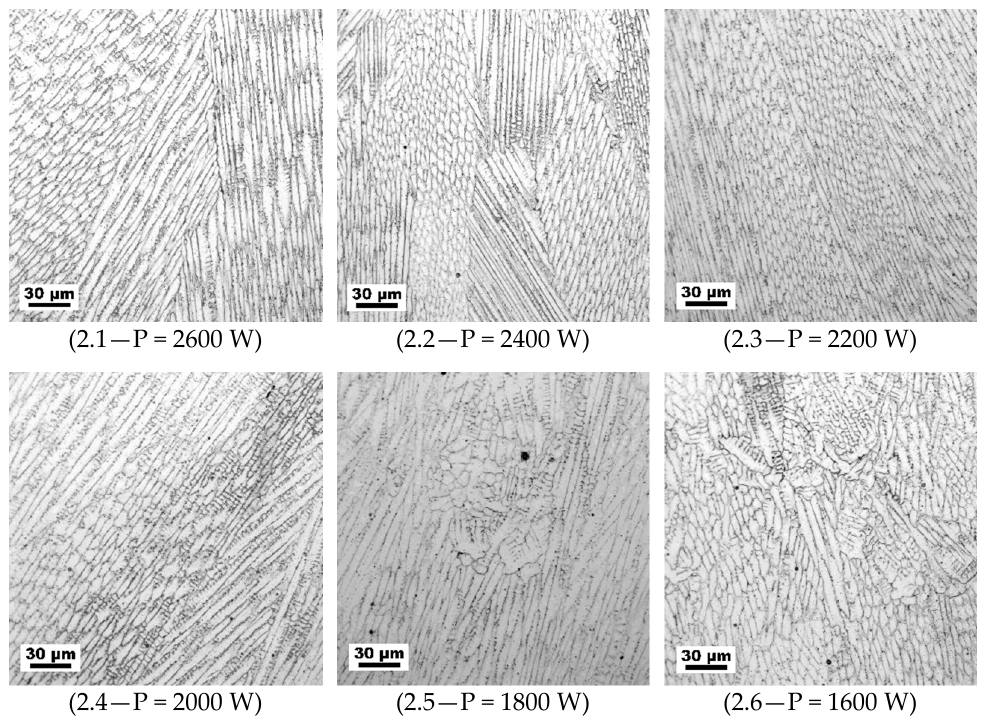
Figure 7. Microstructure of samples with different production power, laser power in the range of P = 2600 W ( 2.1 ) to P = 1600 W ( 2.6 ).